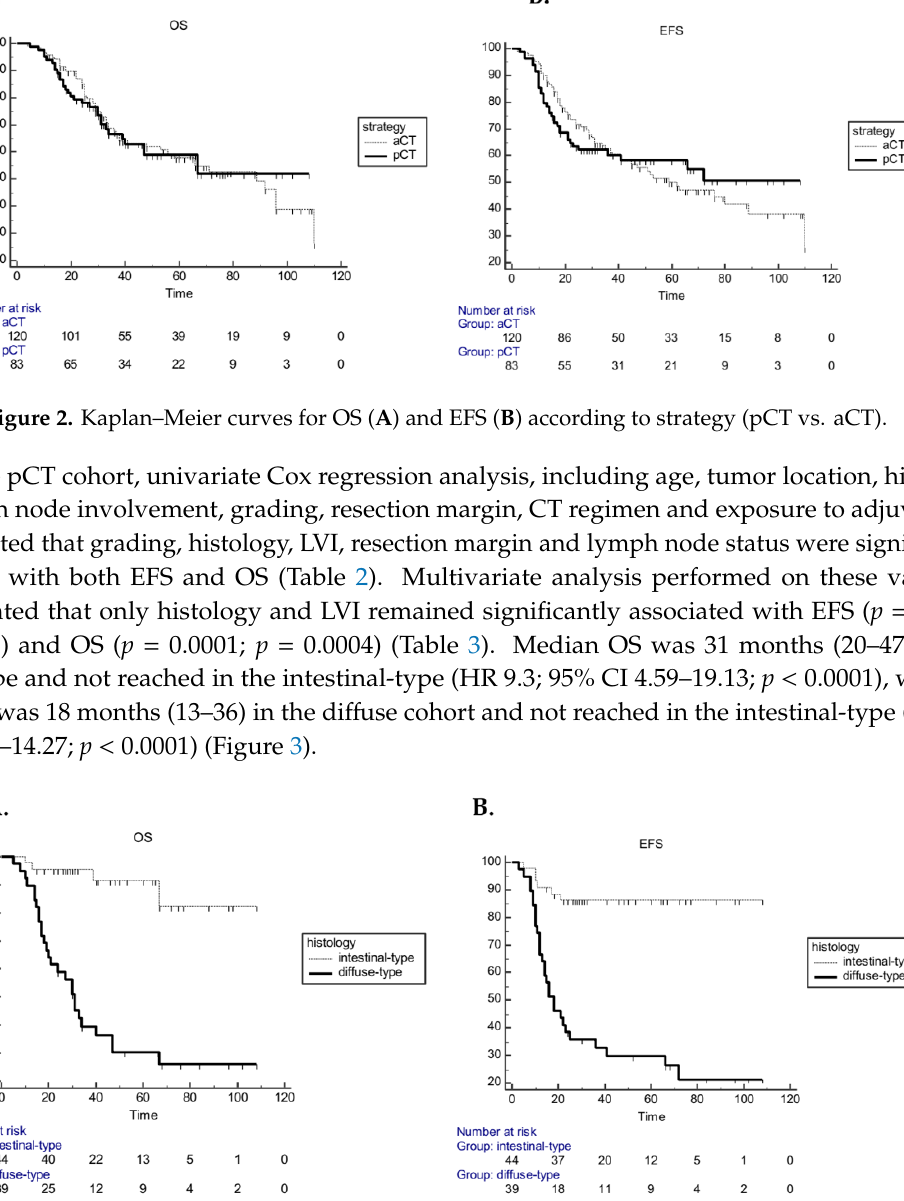
Figure 3. Kaplan–Meier curves for OS ( A ) and EFS ( B ) in the pCT cohort according histology (intestinal vs. diffuse subtype, HR 9.3; 95% CI 4.59–19.13; p < 0.0001 for OS; HR 7.2; 95% CI 3.6–14.27; p < 0.0001 for EFS).